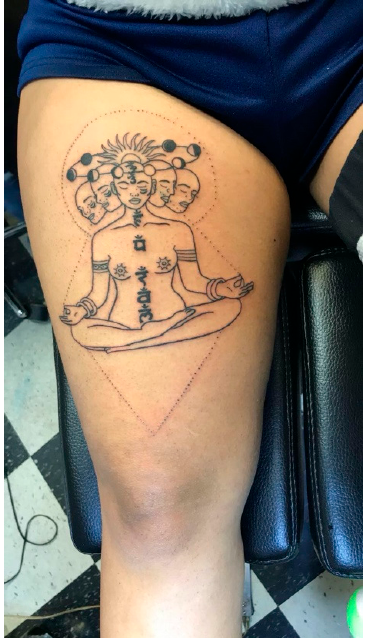
Figure 2. Keke’ goddess on her leg, facing outwards.